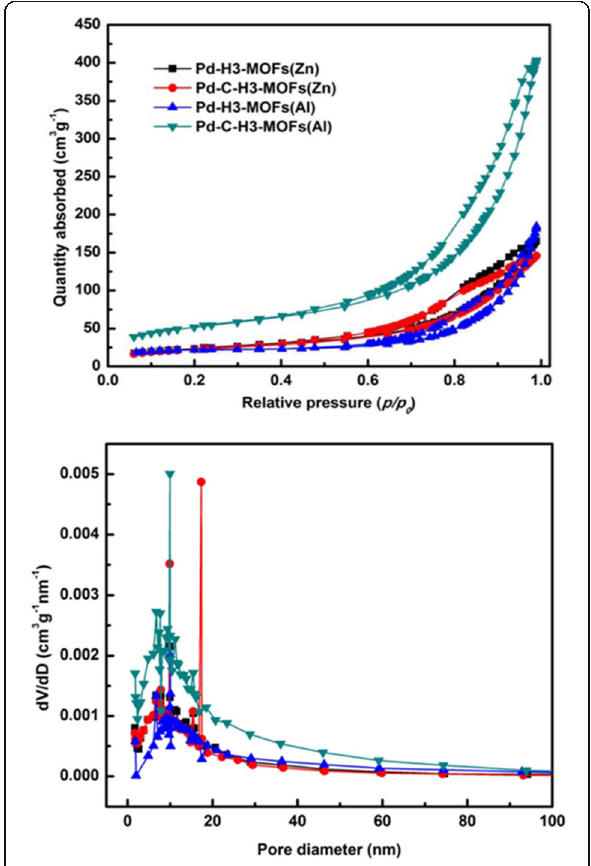
Fig. 6 a Nitrogen adsorption – desorption isotherms of Pd-H3- MOFs(Zn), Pd-H3-MOFs(Al), Pd-C-H3-MOFs(Zn), and Pd-C-H3-MOF- s(Al) samples and b their corresponding pore size